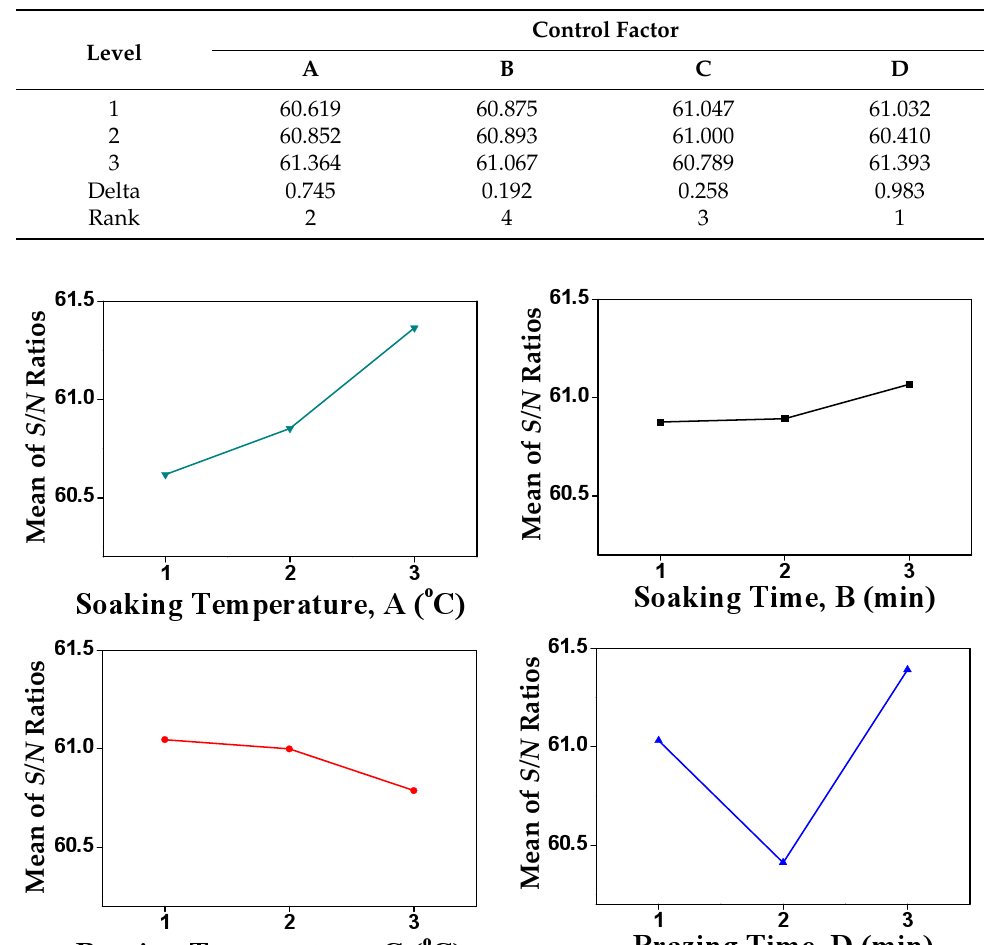
Figure 5. Main effects of the S / N ratios.